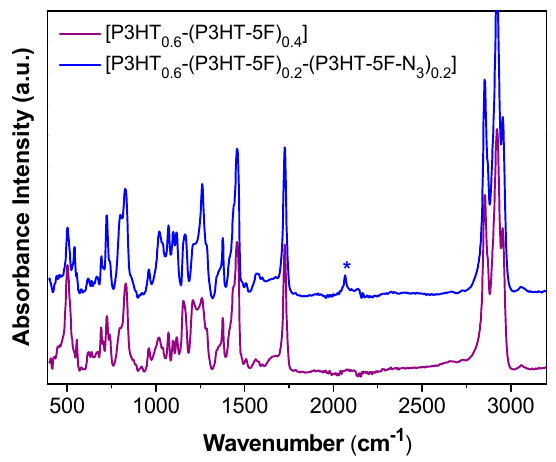
Figure 4. ATR spectra of the [P3HT 0.6 -(P3HT-5F) 0.4 ] and azide [P3HT 0.6 -(P3HT-5F) 0.2 -(P3HT-5F-N 3 ) 0.2 ] (the asterisk indicates the azide functionality).